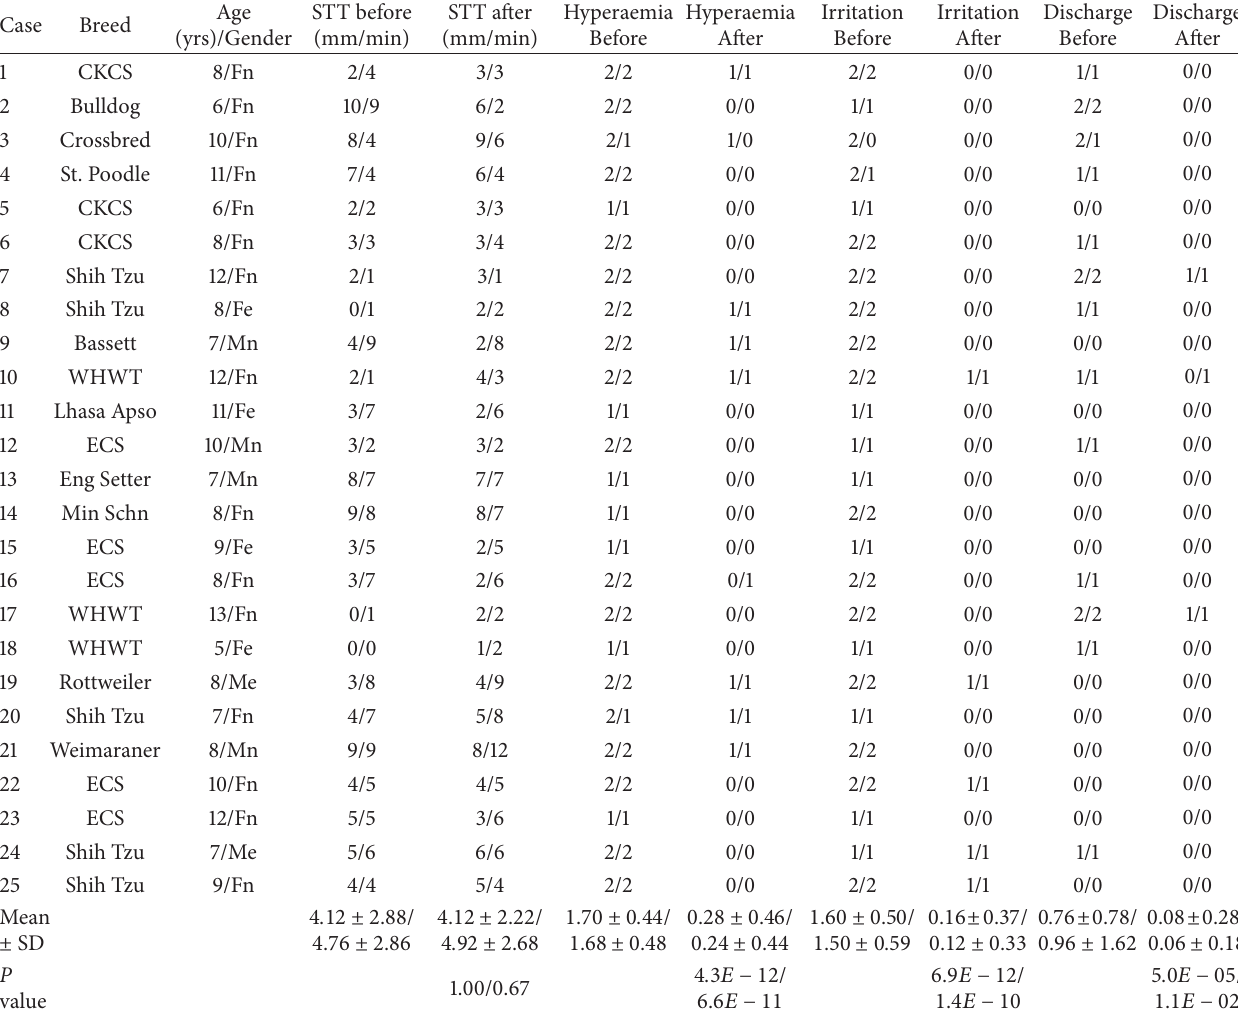
Table 1: Scores of ocular health before and after 2 weeks of treatment (twice daily) of the xCMHA-S gel in a clinical study on dogs.